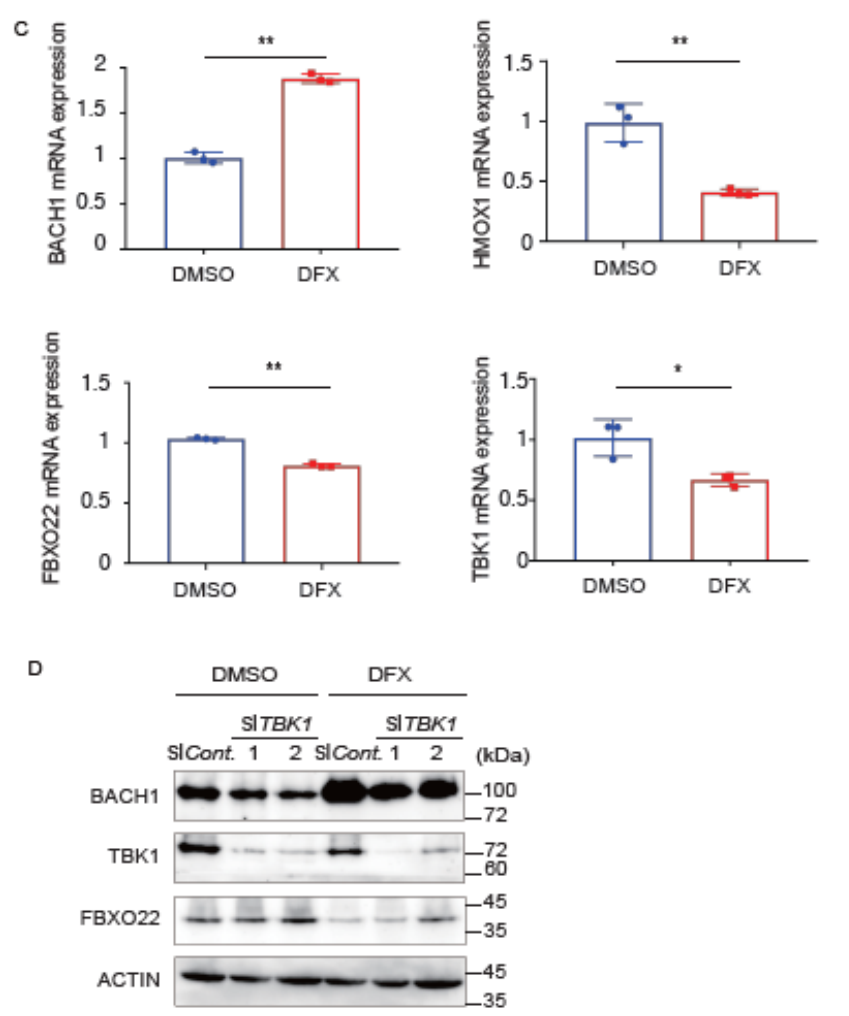
Figure 4. The increases of BACH1 mRNA and protein under iron deficiency. ( A ), Western blotting of BACH1 protein. AsPC − 1 cells were treated with DFX (100 µ M) or FeSO 4 (200 µ M) for 24 h or 48 h and cell lysates were used for Western blotting with anti- BACH1 and anti-actin antibodies. DMSO served as a negative control. ( B ), Western blotting of BACH1 protein. AsPC − 1 cells were incubated with indicated concentrations of DFX for 6, 12, 24 or 48 h. Proteins were detected as in ( A ). ( C ), Relative mRNA levels of indicated genes. AsPC − 1 cells were incubated with DFX (50 µ M) or DMSO for 12 h. mRNA amounts were normalized using actin mRNA and presented as mean ± SD, with p values from the Student’s t -test. n = 3 biologic replicates for each experiment, *, p < 0.05; **, p < 0.01. ( D ), Western blotting of BACH1 , TBK1 and FBXO22 proteins. At 24 h after TBK1 knockdown, cells were incubated with DFX (50 µ M) or DMSO for 48 h and were used for Western blotting. DMSO served as a negative control.